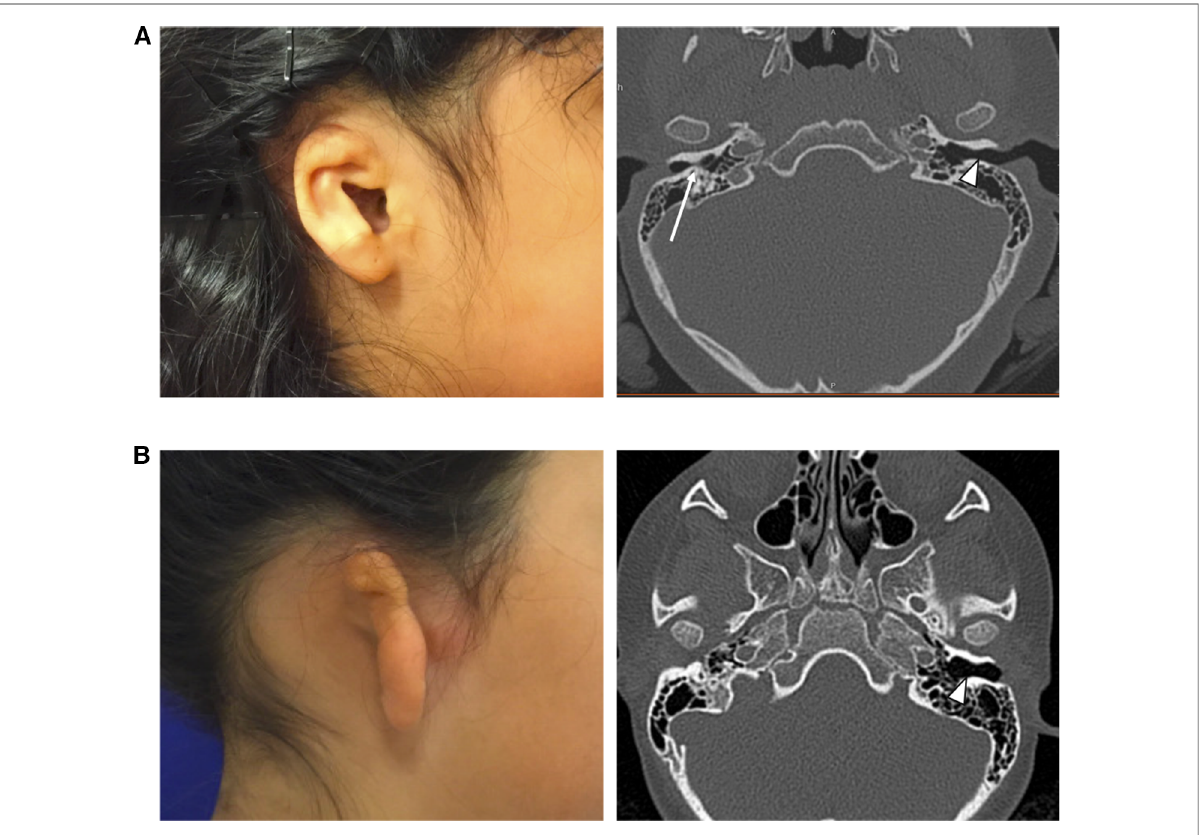
FIGURE 2 ( A ) Child with visible canal opening on the right, but severe bony external canal stenosis demonstrated on non-contrast CT scan (long white arrow). Normal canal size is noted on the contralateral side (short white arrow). ( B ) Child with complete atresia on the right, demonstrated on non-contrast CT scan. Normal canal size is noted on the contralateral side (short white arrow).